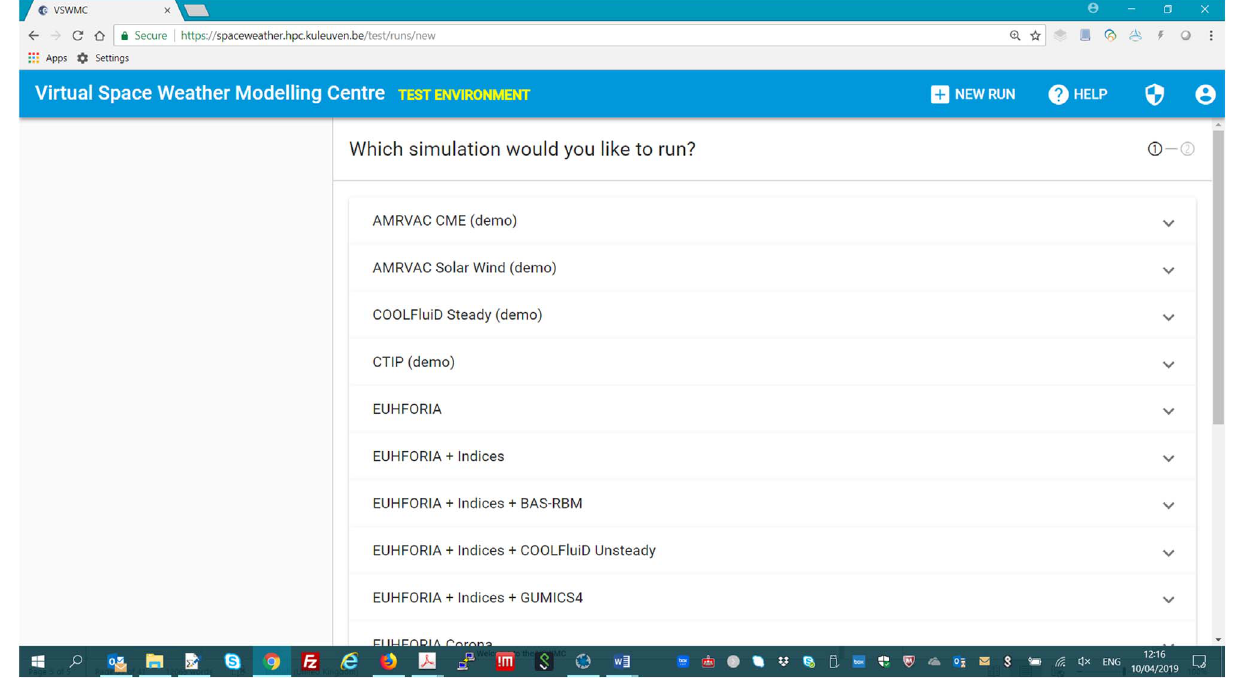
Fig. 7. Choice offered when requesting a new run (in the test environment system).